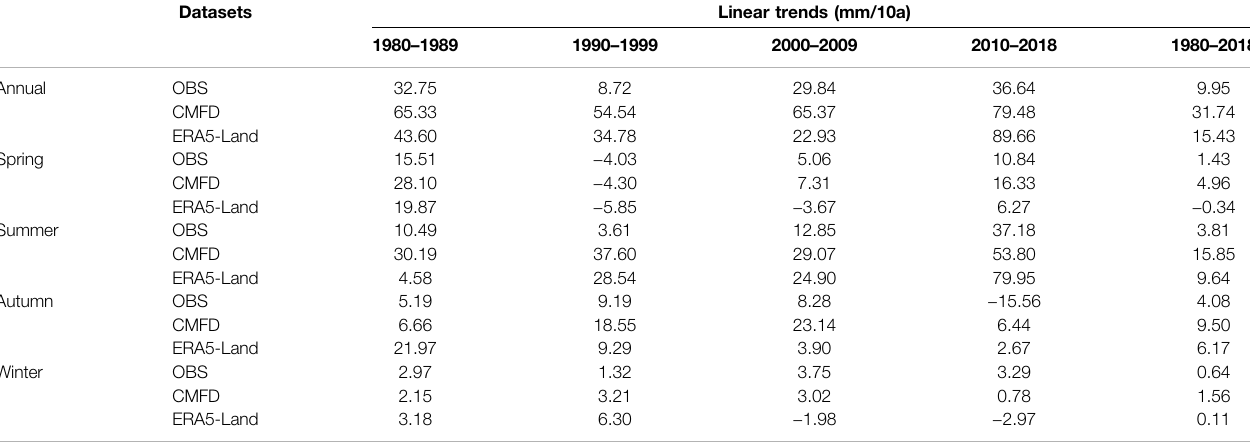
TABLE 3 | Precipitation trends of the Qilian Mountains from 1980 to 2018 based on OBS, CMFD, and ERA5-Land; OBS is the average of 28 observation stations.